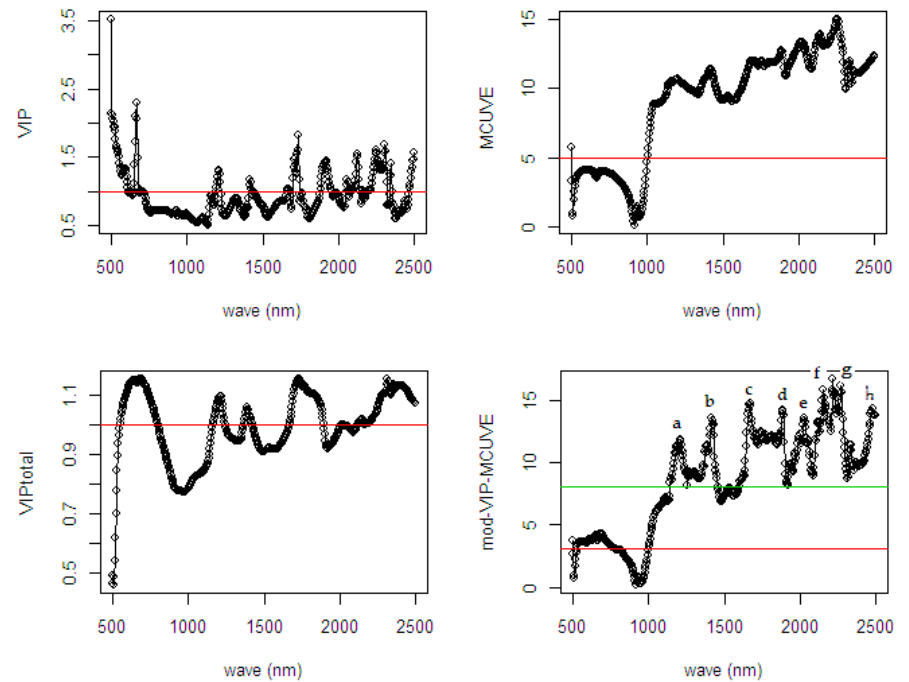
Figure 9. Comparison of selected wavelengths from different wavelength selection methods using spectral data of ground dried mesocarp on the %FFA.